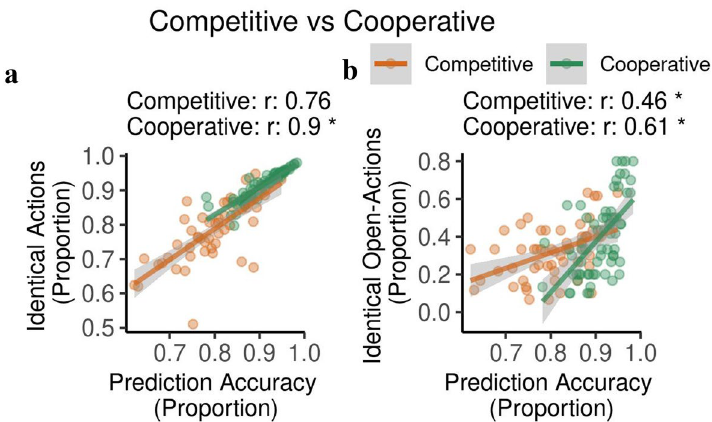
Figure 13. Correlations relating choice and prediction indices. We observed significant correlation between ( a ) prediction accuracy and identical actions with significance between the contexts. We also observed significant correlation between ( b ) prediction accuracy and identical open